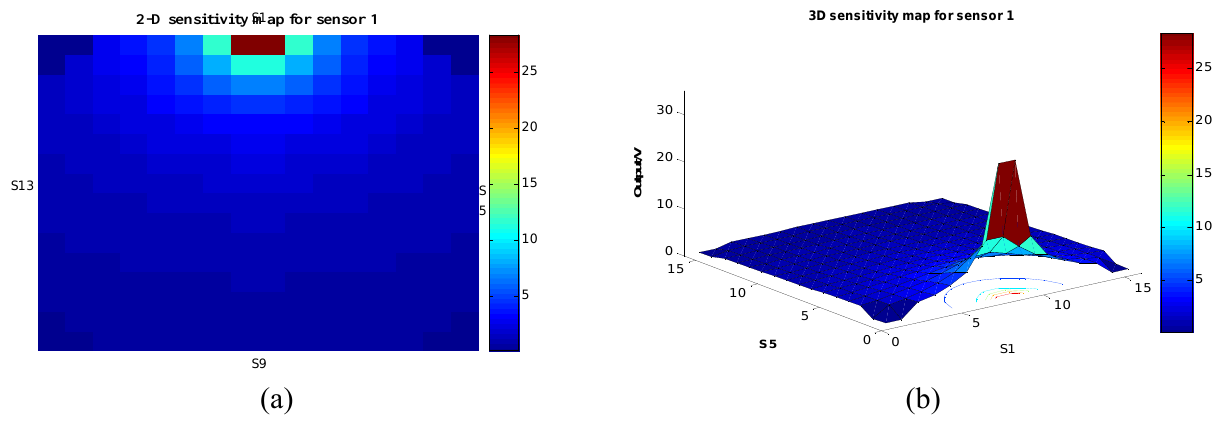
Figure 7 . Sensitivity map for sensor 1 (a) Two dimensional (b) Three